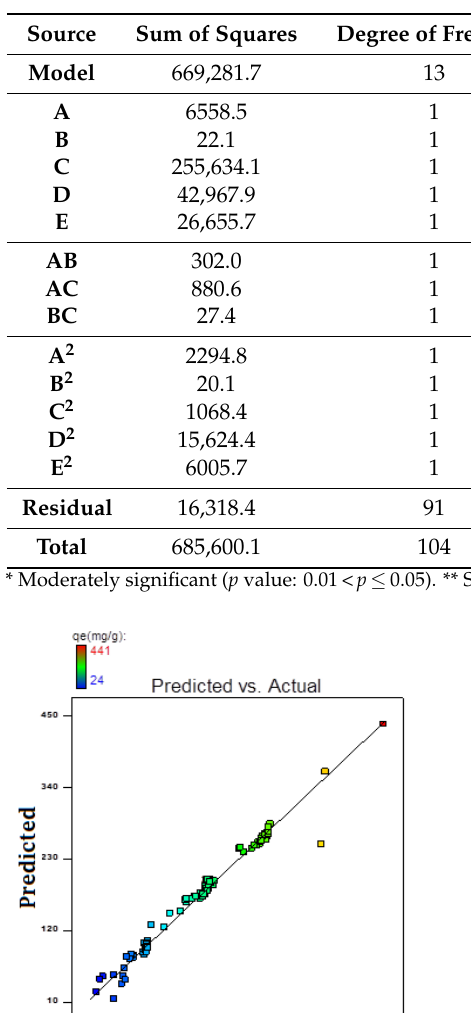
Table 7. ANOVA for fractional factorial experimental design of AR119 – NICUS system. Source